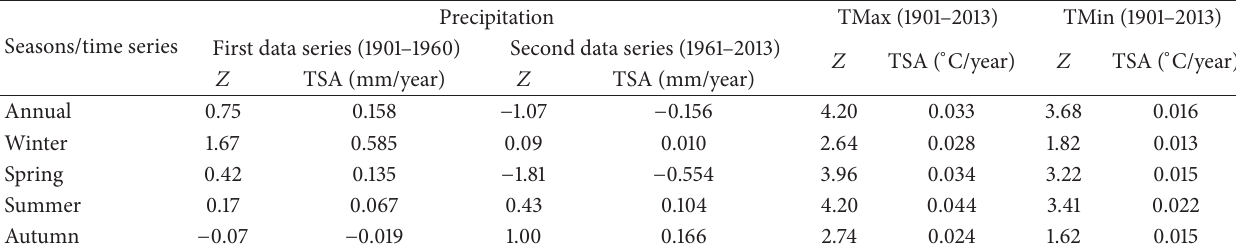
Table 6: Statistical results of the average precipitation and temperature data related to the whole study